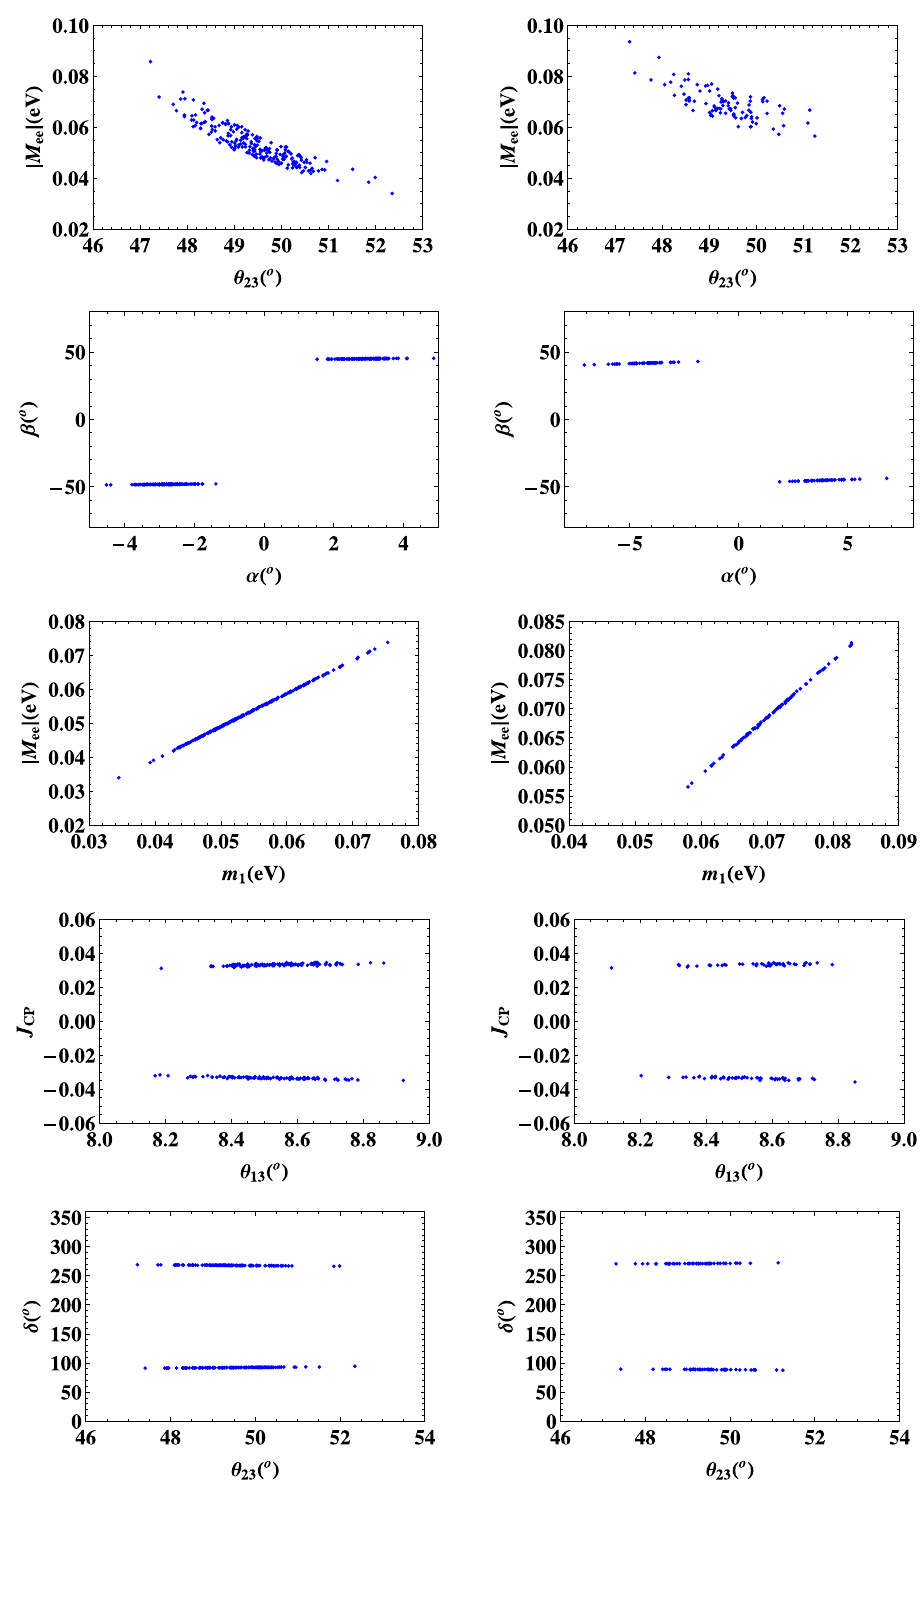
Fig. 2 Correlation plots for textures B 2 -NH(left panel) and B 4 -IH (right panel) under LMA